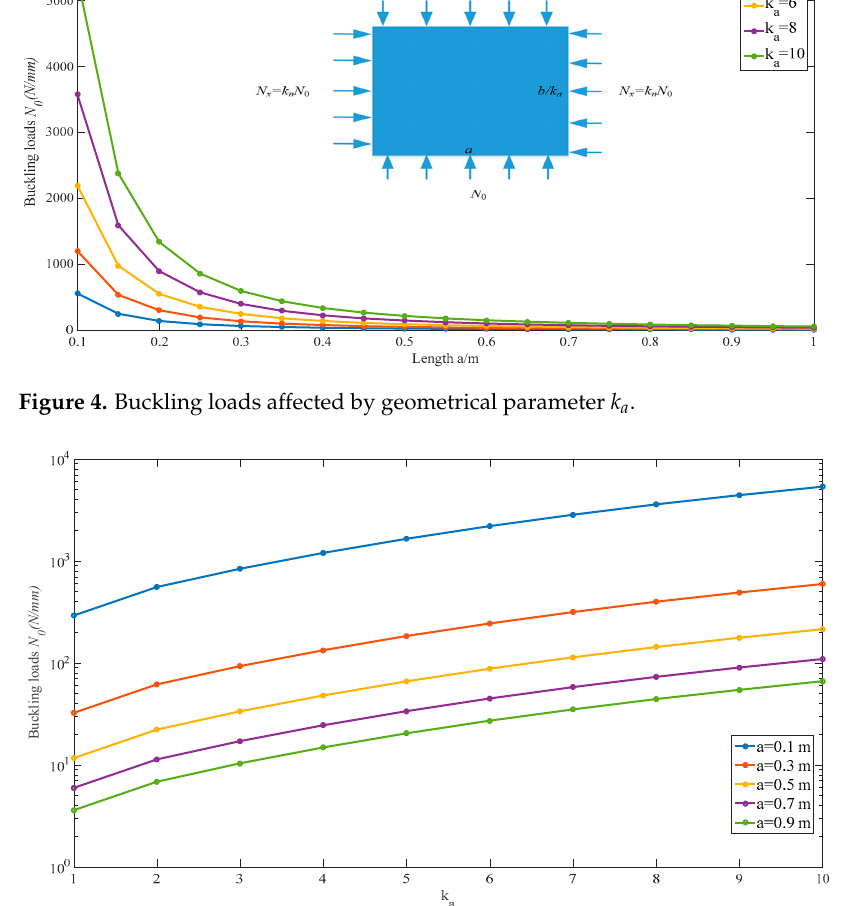
Figure 5. Buckling loads affected by geometrical parameter k a and the dimensions.